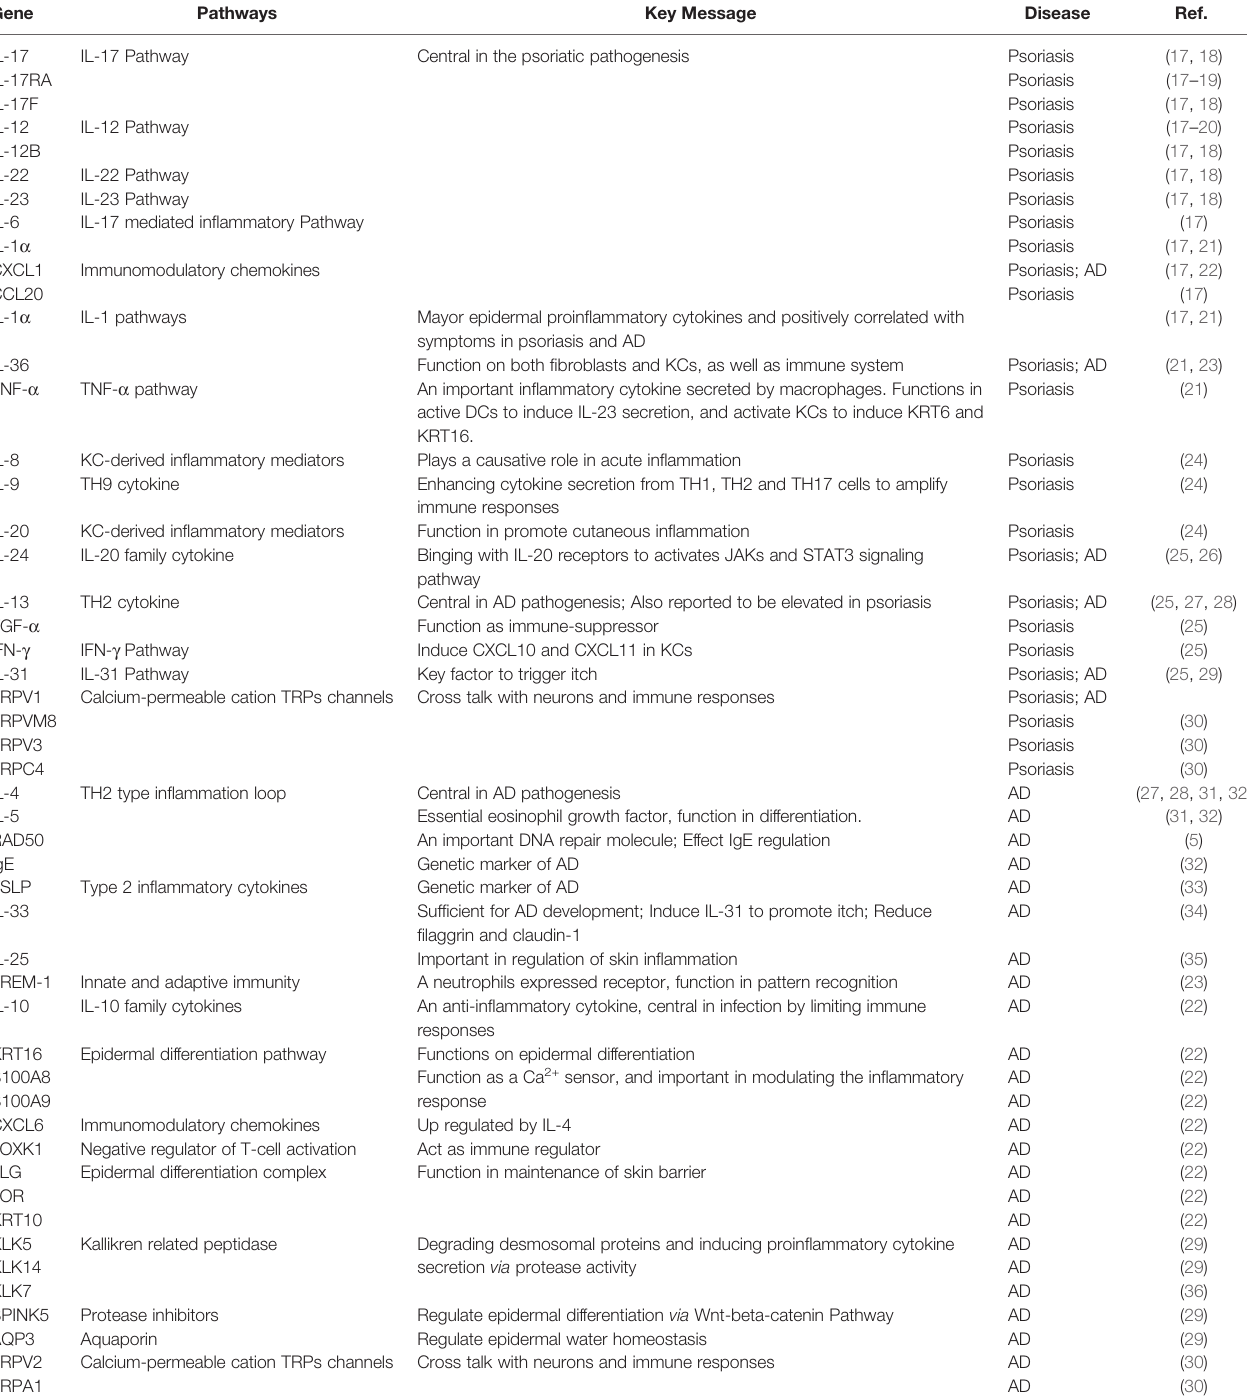
TABLE 1 | Deregulated genes in AD and